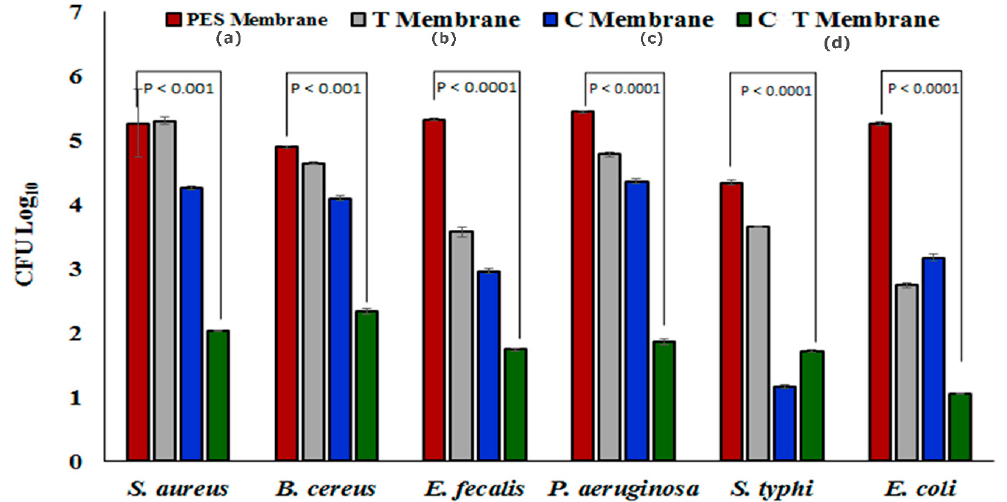
Figure 6. Graph showing bacterial decline in the (a) pure polyethersulfone (PES) membrane, (b) terpene embedded polyethersulfone (T-PES) membrane, (c) cannabinoid embedded polyethersulfone (C-PES) membrane, and (d) cannabinoid and terpene embedded polyethersulfone (CT-PES) membrane.